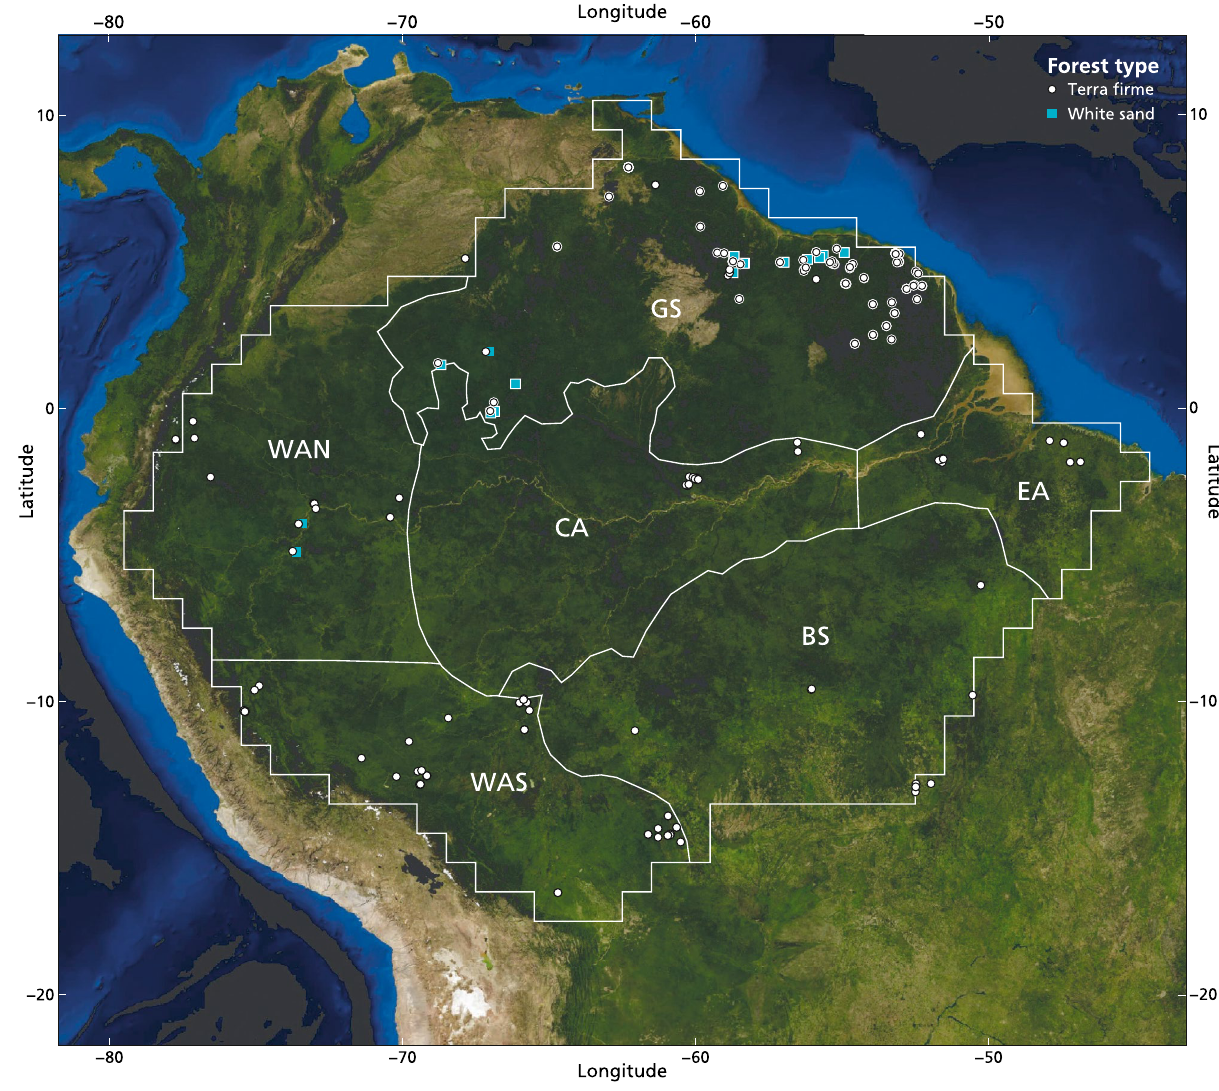
Figure S1.1 for the Guiana Shield dataset plots only). For each plot, the forest type is indicated by symbols, where white circle = terra firme forest, and blue square = white sand forest. Approximate borders of the six biogeographical regions of Amazonia, reproduced from ter Steege et al. 32 , are indicated with white lines. Abbreviations for the regions are GS = Guiana Shield, BS = Brazilian Shield, WAN = north-western Amazonia, WAS = south-western Amazonia, CA = central Amazonia, and EA = eastern Amazonia. Figure created in R 43 , background satellite imagery of South America by NASA 44